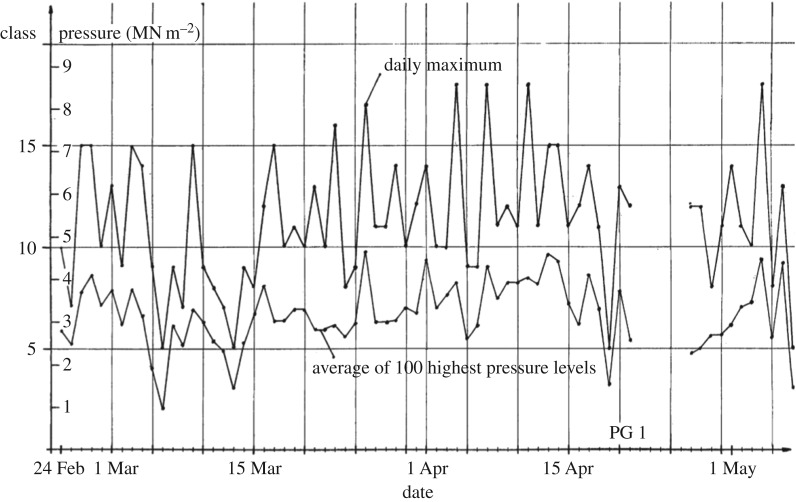
The measured daily maximum ice pressures [9].